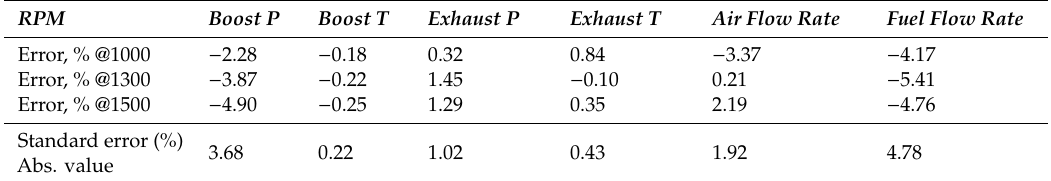
Table 4. Detailed errors and standard errors for validation results for data shown in Figure 2.